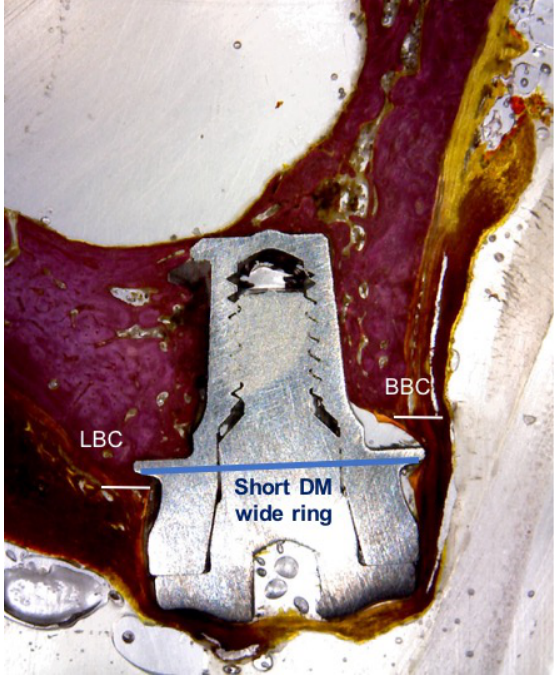
Figure 7. Wide ring extra-short implant.